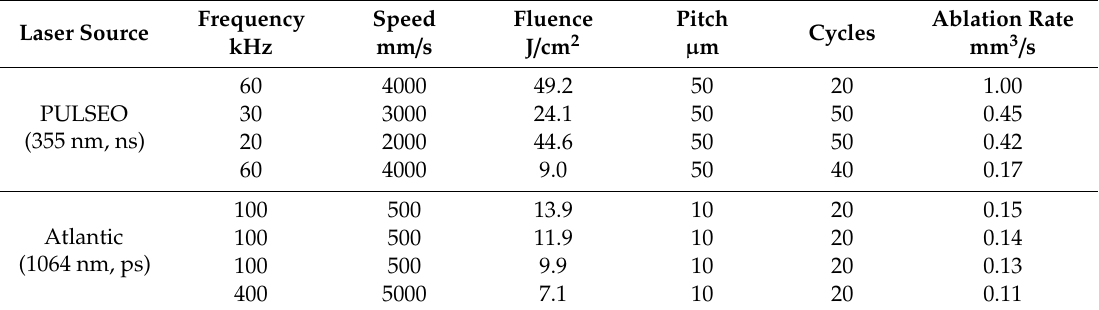
Table 2. Process parameters leading to better results with both lasers, and ablation